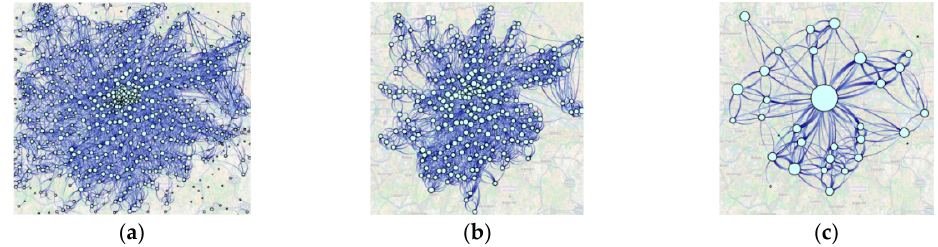
Figure 45. Visualization of London resident-mobility data [120]: ( a ) original flows; ( b ) filtered flows are cluttered; and ( c ) aggregated flows revealing the spatial patterns.